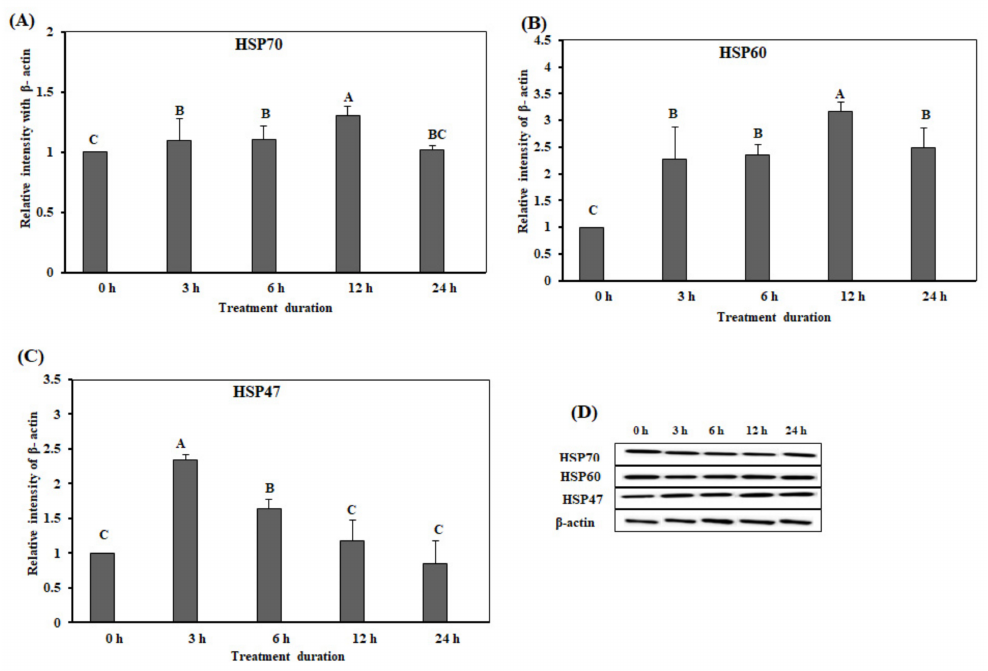
Figure 6. The protein expression of the heat shock proteins in the ileum of chickens exposed to acute heat stress for di ff erent durations of time ( n = 8). The mean relative expression of HSP70 ( A ), HSP60 ( B ), and HSP47 ( C ). ( D ) Western blot analysis results. A–C HSP70 , HSP60 , and HSP47 in the columns with the di ff erent superscript letters di ff er significantly ( p < 0.05) among the di ff erent heat exposure